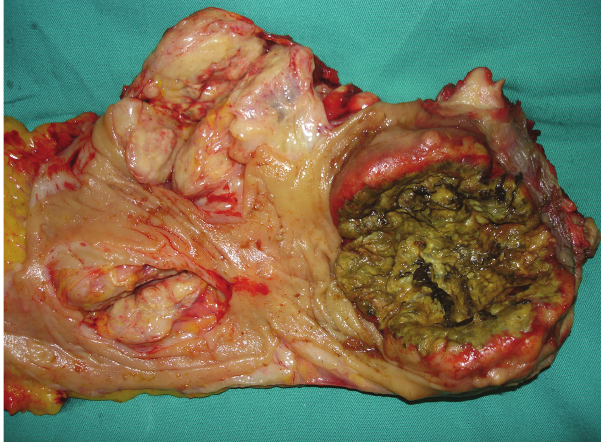
Figure 2 - The rectum, the large nodes, and the tumor after an abdominalperineal